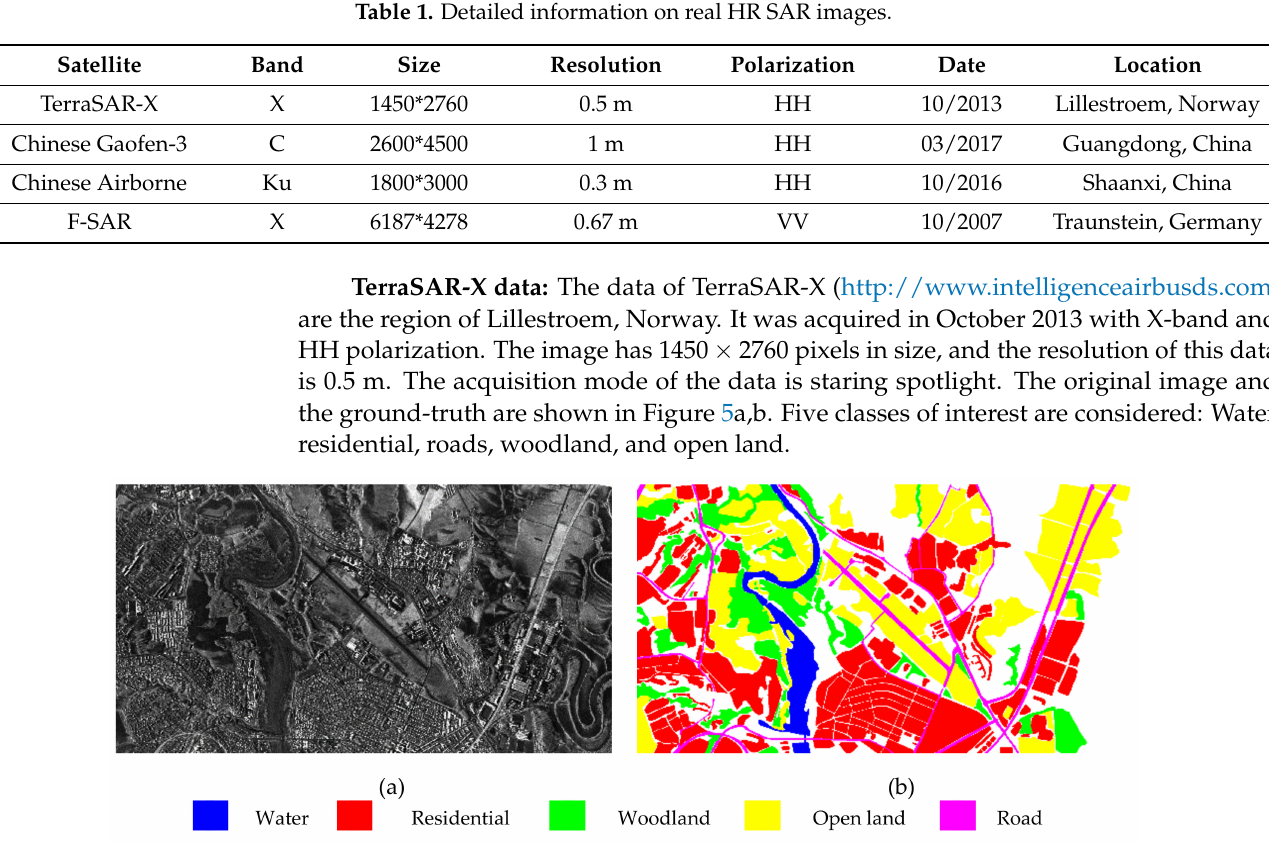
Figure 5. TerraSAR-X SAR image. ( a ) Original SAR image. ( b )